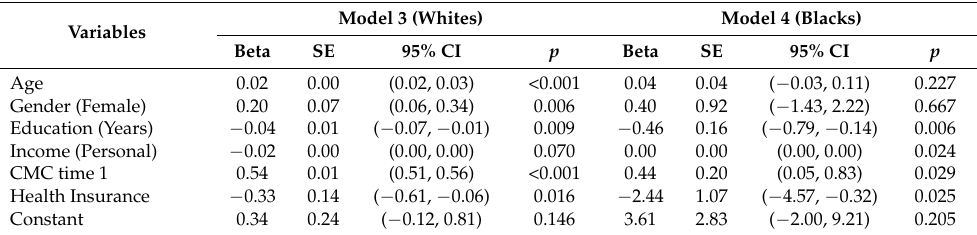
Table 3. Linear regressions in Whites and Blacks based on the association between healthcare insurance and incidence of chronic medical conditions (CMC) over 10